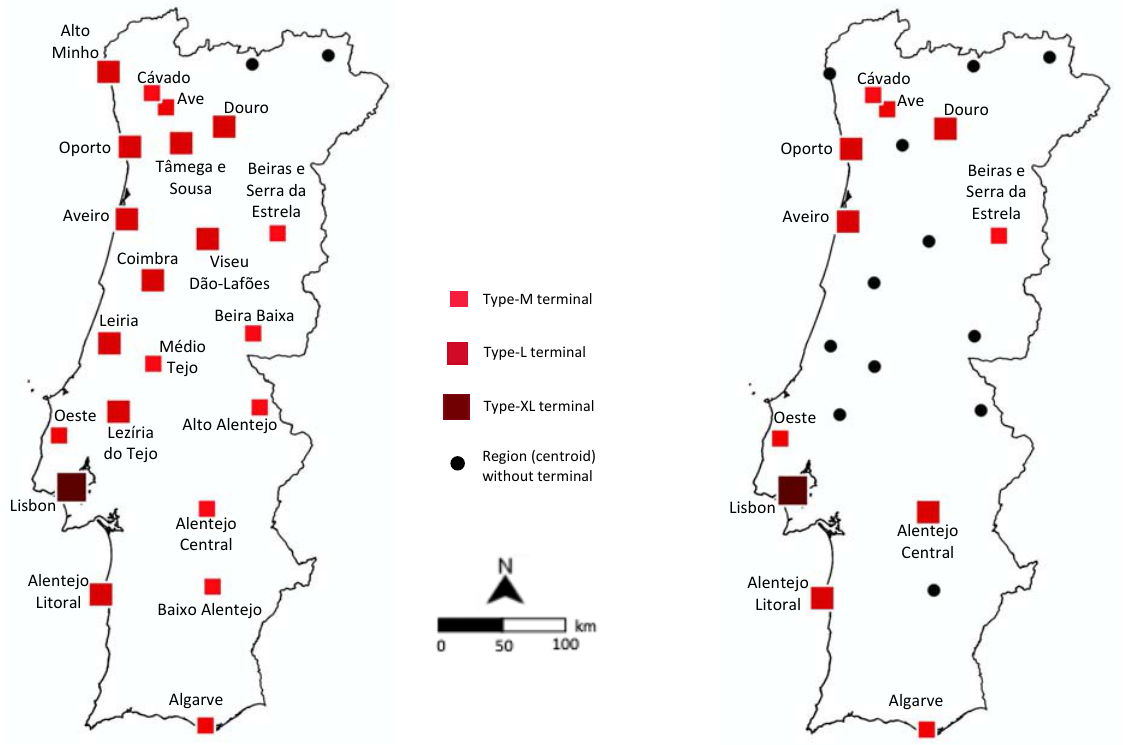
Figure 8. Optimal locations and types of intermodal terminals under centralized management ( left ) and under decentralized management ( right ). Table 4. Main features of the current and optimal intermodal terminal networks.